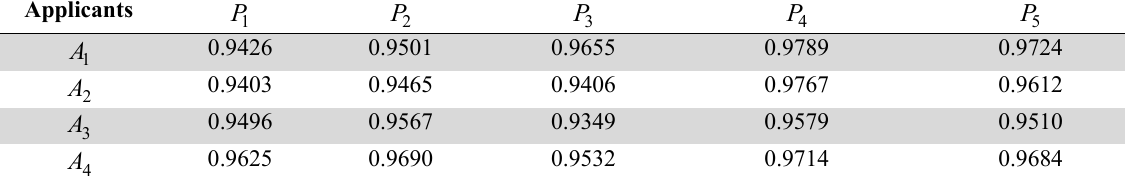
Similarity measure of Applicants vs. Positions using (5) and Type-1 score function